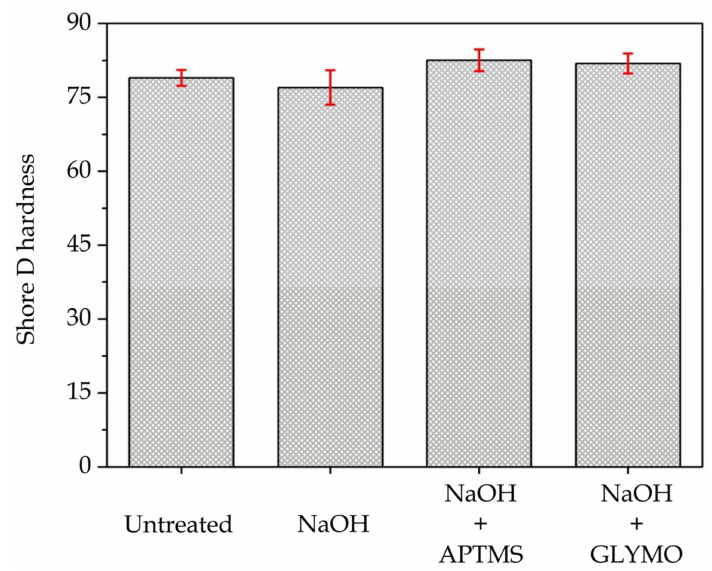
Figure 6. Bar plot of the hardness (Shore D) of PO fibreboards with different surface treatments.